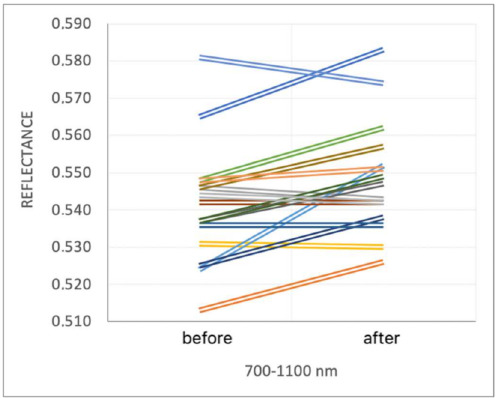
Figure 9. Average results of 3 reflectance measurements at a wavelength of 700–1100 nm in every woman undergoing microdermabrasion, before and after the procedure.